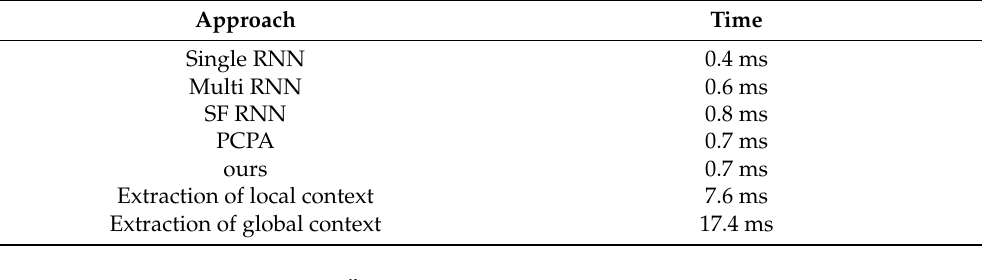
Table 3. Comparison of calculation time of different methods.